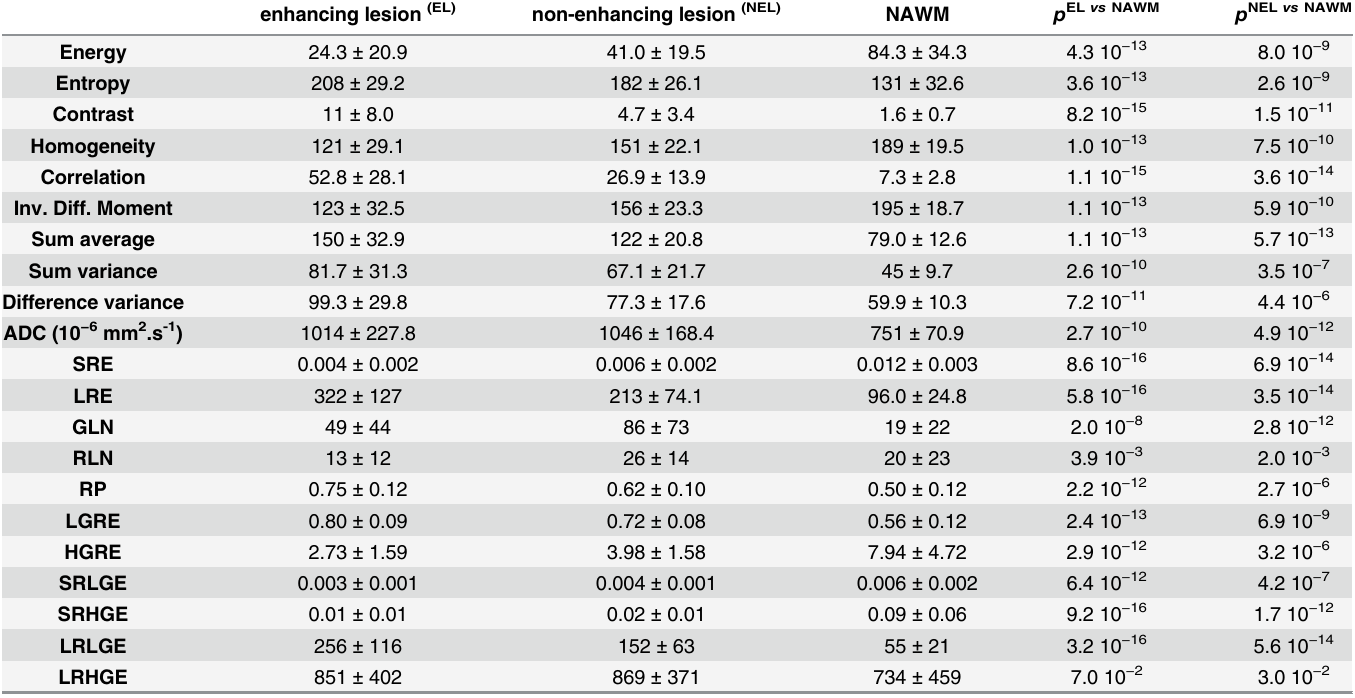
Table 2. Mean values ( ± standard deviation) of texture parameters and ADC parameter. The highly significant p -values observed demonstrate that the texture within NAWM is different when compared to MS lesions (enhanced or unenhanced), suggesting differences in the actual structure of the two tissues. Entropy was found higher in enhanced lesions when compared to unenhanced ones, suggesting that the randomness of gray levels was higher. This was confirmed by the lower Homogeneity and Energy in this type of lesion. Overall, this may suggest that the histologic substrate of enhancing lesions is more het- erogeneous; an assumption that, however, needs to be investigated on experimental models allowing comparison between texture patterns and anatomo- pathological substrate to be